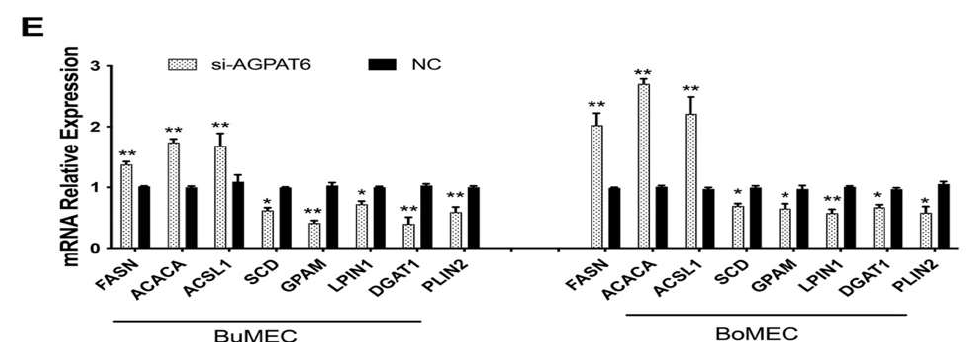
Figure 3. AGPAT1 and AGPAT6 regulated the TAG synthesis of BuMECs and BoMECs. ( A ) The interference efficiency analysis of AGPAT1 and AGPAT6 in BuMECs and BoMECs, respectively; ( B ) Effect of AGPAT1 knockdown on the TAG content of BuMEC and BoMECs; ( C ) Effect of AGPAT6 knockdown on the TAG content of BuMEC and BoMECs; ( D ) effect of AGPAT1 knockdown on the expression of genes related to the TAG synthesis in BuMEC and BoMECs, respectively; ( E ) Effect of AGPAT6 knockdown on the expression of genes related to TAG synthesis in BuMEC and BoMECs, respectively. * p < 0.05; ** p < 0.01. si-AGPAT includes the siRNA interference for AGPAT1 or siRNA interference for AGPAT6 ; si-AGPAT1 represents the siRNA interference for AGPAT1 ; si-AGPAT6 represents the siRNA interference for AGPAT6 ; NC indicates the control group.